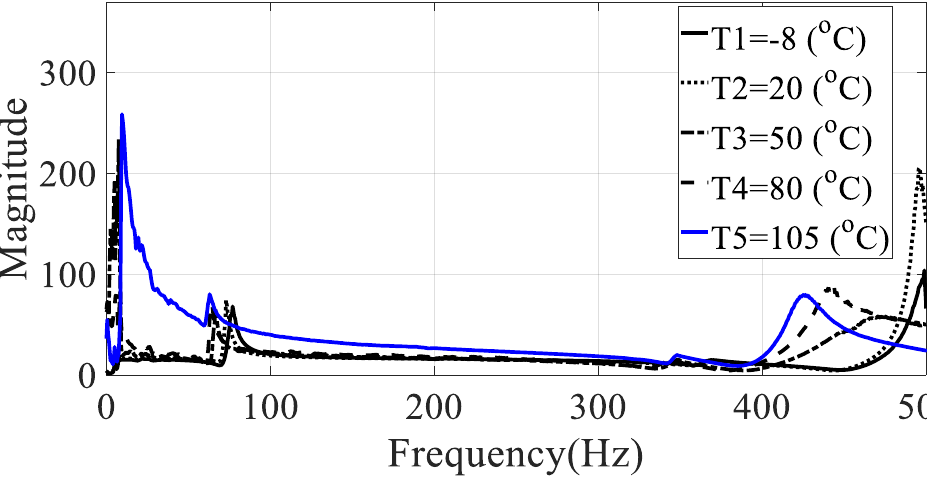
Figure 9. Representative frequency response function of specimen V ( 𝜙 = 90 degrees ).